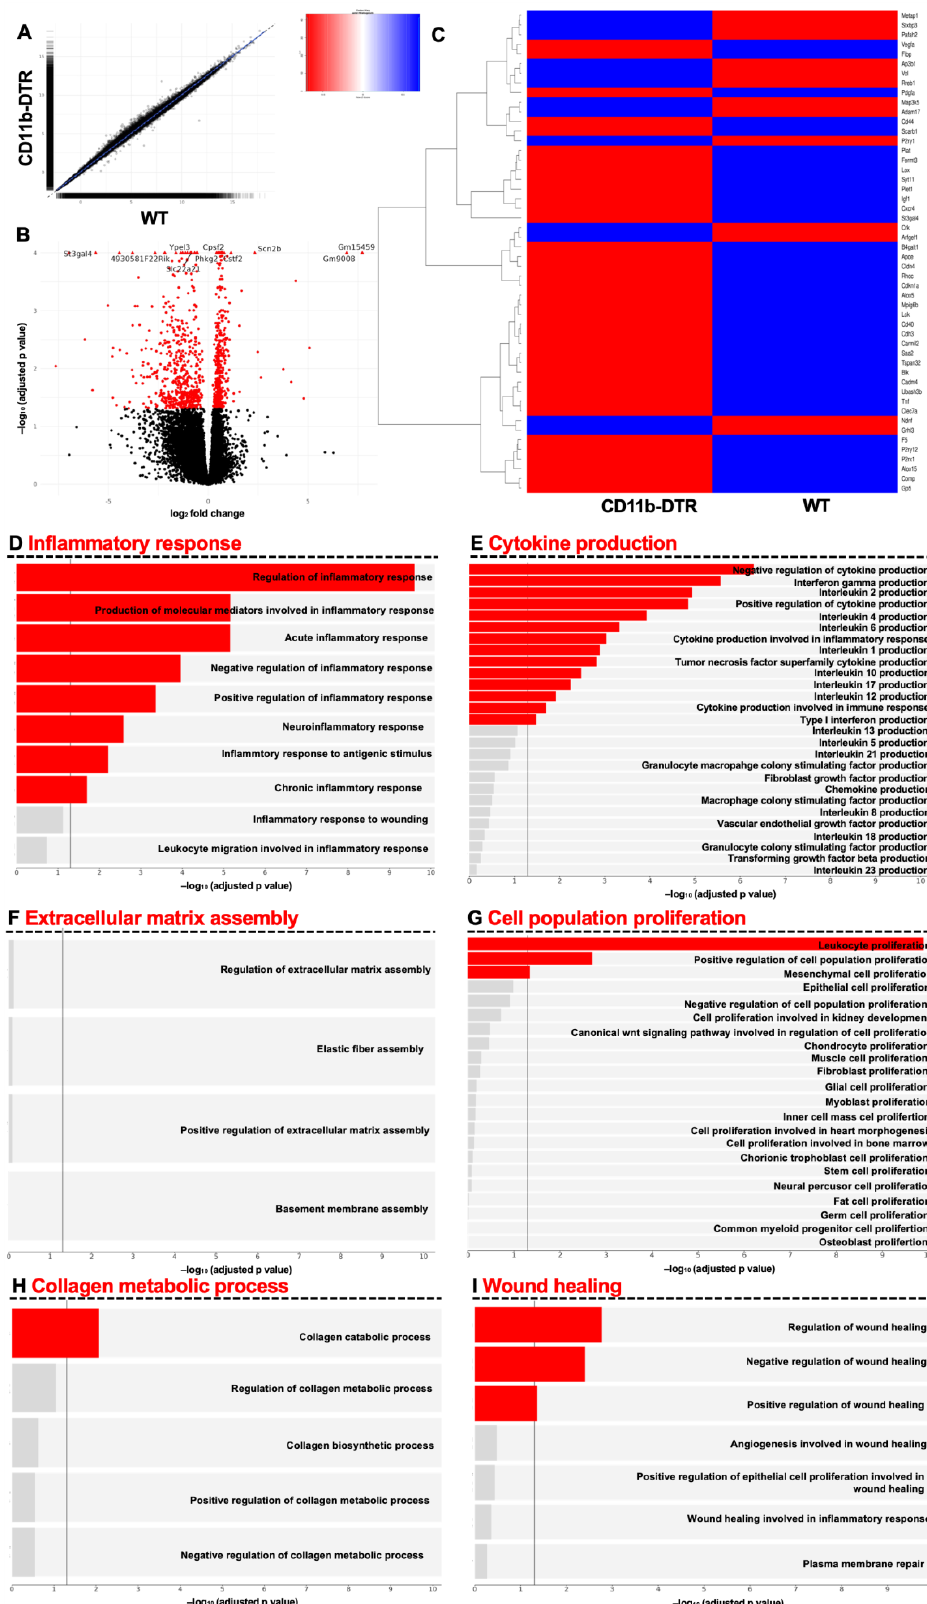
Figure 5. Gene set enrichment analysis of intestinal anastomotic healing during the inflammatory phase. Gene set enrichment analysis (GSEA) results of anastomotic healing (AH) comparing wild type (WT)